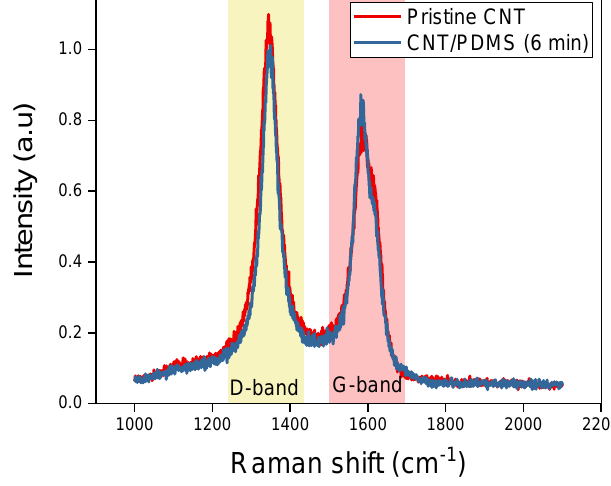
Figure 3. Raman spectra of pristine CNT and CNT composites.